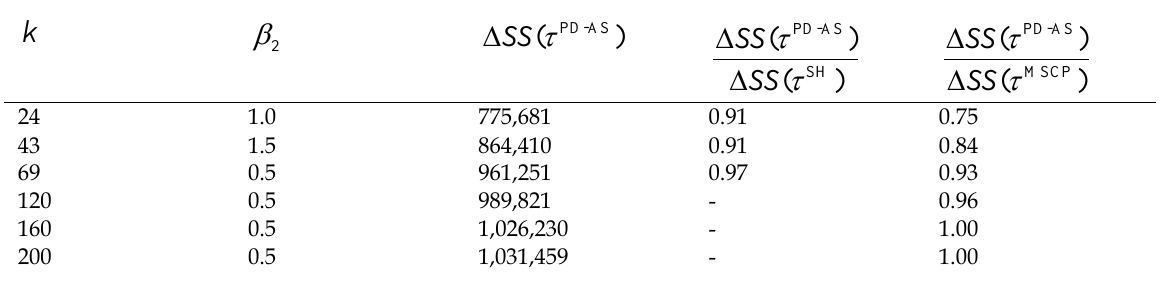
Table 7. Results obtained by using the ascent method for polishing PD τ